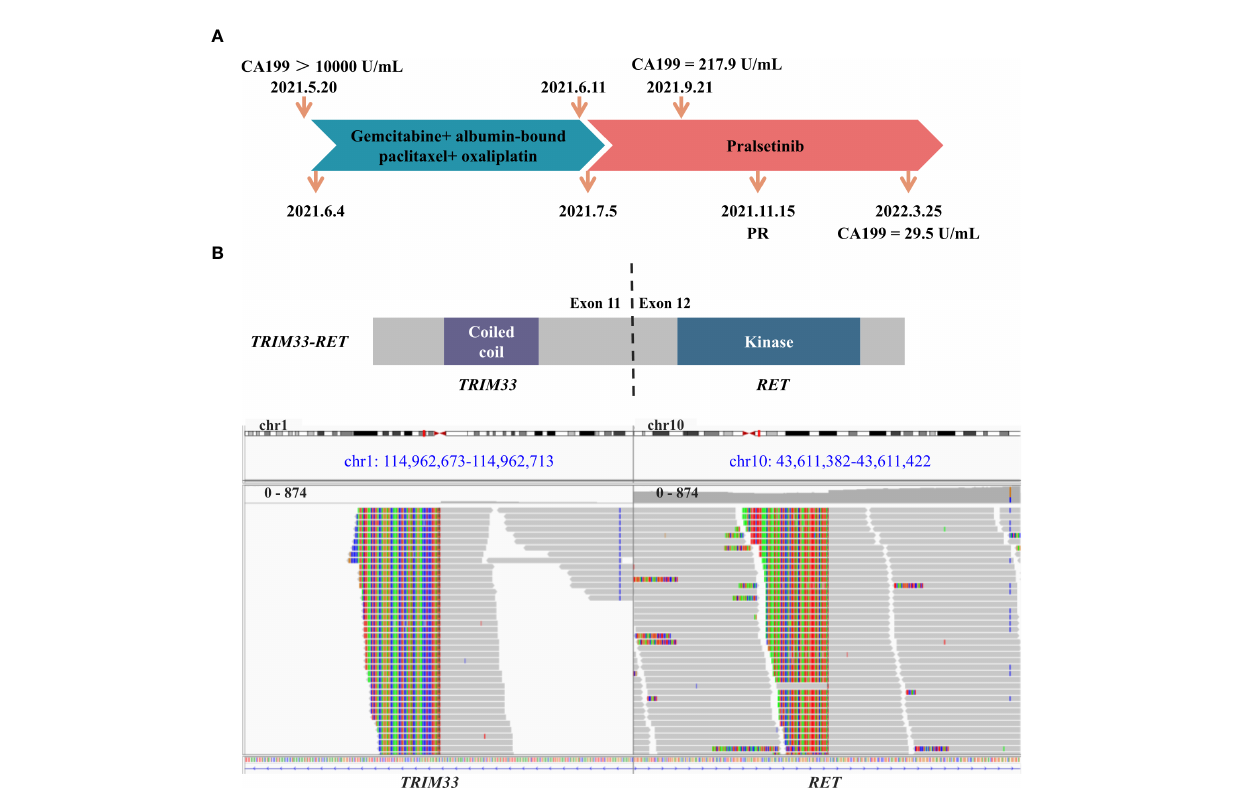
FIGURE 1 Schematic of treatment history and next-generation sequencing (NGS) ‐ detected RET fusion. (A) The timeline of treatment and corresponding CA199 levels. (B) The schematic diagram and identi fi cation of the TRIM33-RET fusion. Sequencing reads of TRIM33 and RET are visualized by the Integrative Genomics Viewer